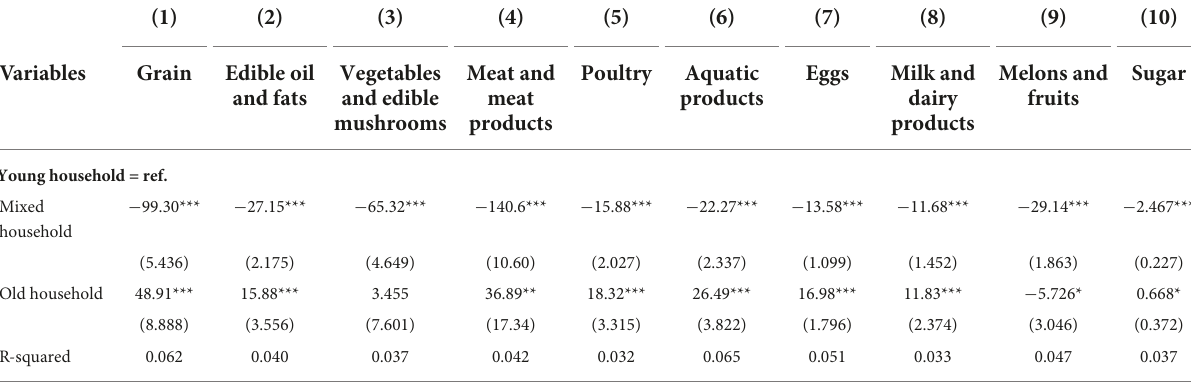
TABLE 3 Regression of the food consumption per capita on the household composition.